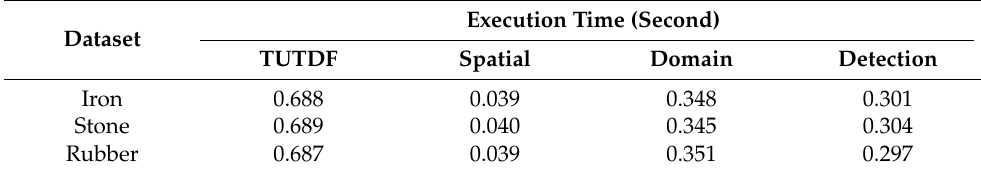
Table 8. Execution time of different